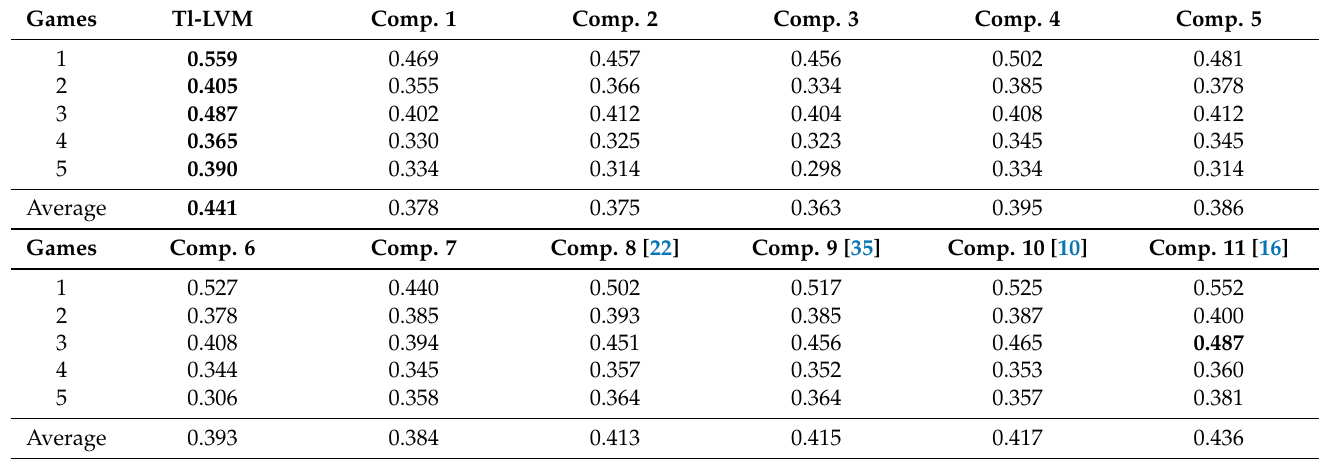
Table 3. F-measure of important scene prediction in Tl-LVM and Comps. 1–11. Bold values represent the highest